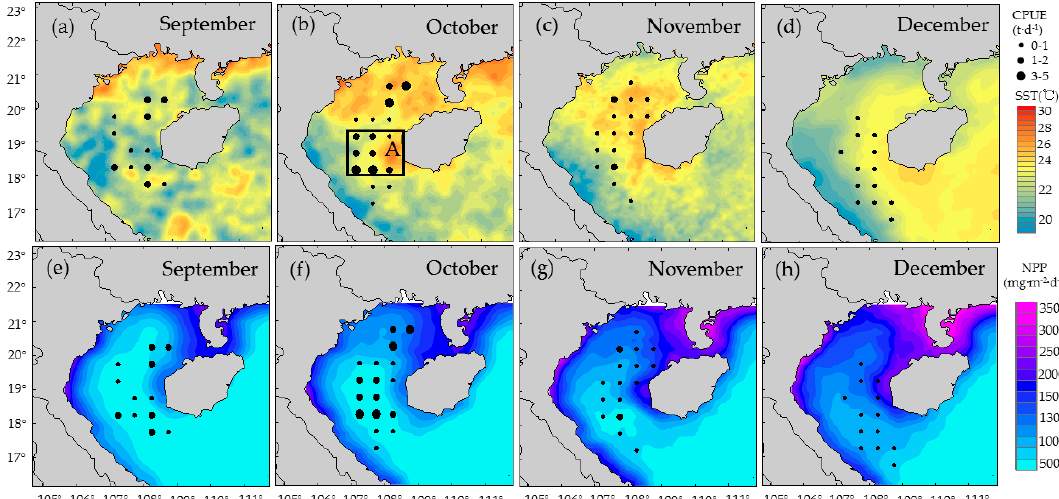
Figure 2. Spatial distribution of sea surface temperature (SST), net primary production (NPP) and catch per unit e ff ort (CPUE) in the Beibu Gulf: ( a ) SST in September, ( b ) SST in October, ( c ) SST in November, ( d ) SST in December, ( e ) NPP in September, ( f ) NPP in October, ( g ) NPP in November, ( h ) NPP in